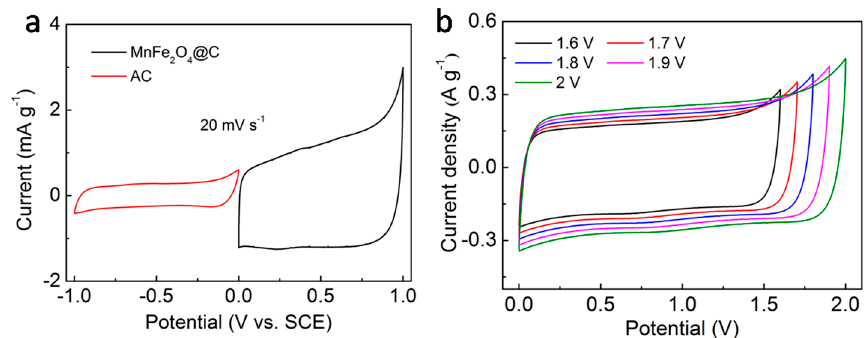
Figure 6. CV curves ( a ) of the MnFe 2 O 4 @C and AC electrodes measured in a three-electrode system, CV curves ( b ) at various working voltage of the MnFe 2 O 4 @C // AC device.